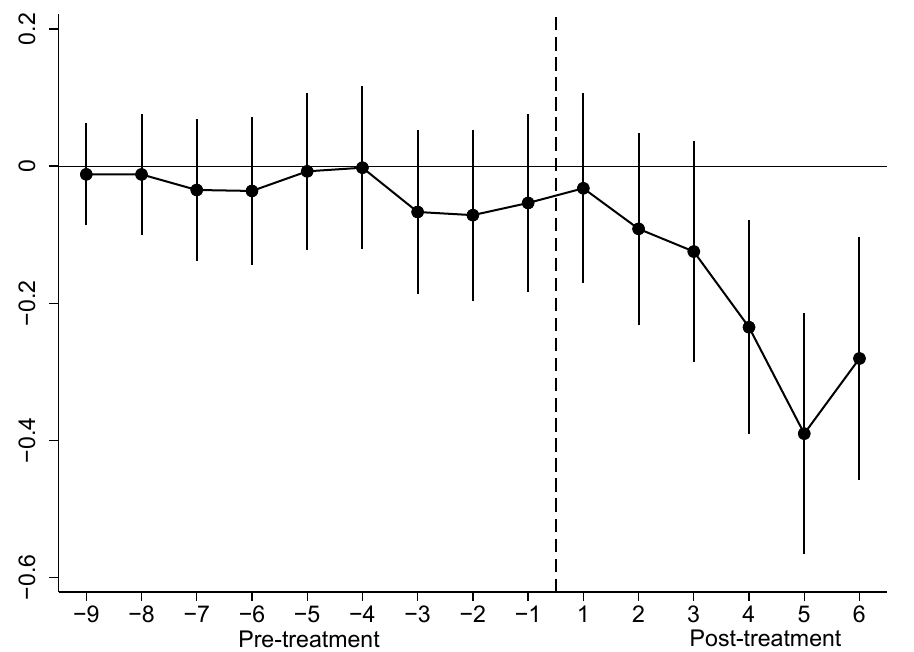
Figure 1. Pretreatment trend and annual treatment effects.